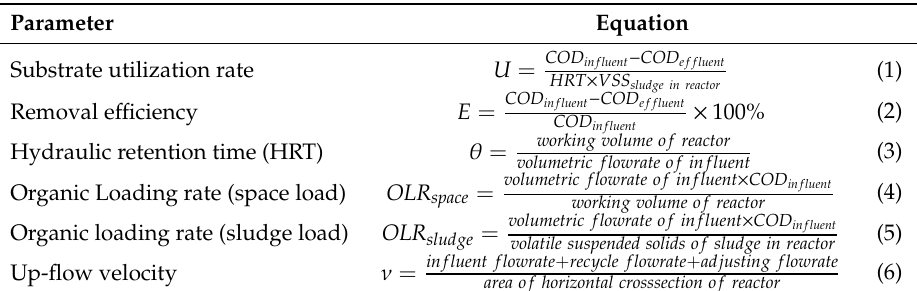
Table 7. Main operational parameters of UASB.